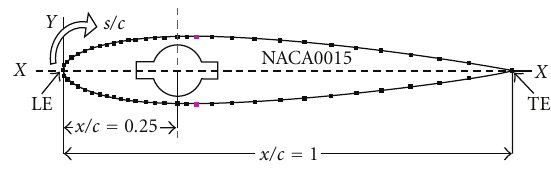
Figure 2: unsteady flow reversal on an oscillating airfoil [17].